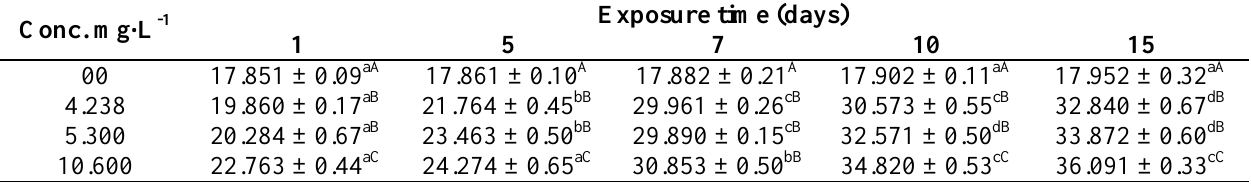
Table 5. Activity of Superoxide dismutase (unit/mg protein) in the liver of C. punctatus exposed to sub-lethal doses of Atrazine for 1–15